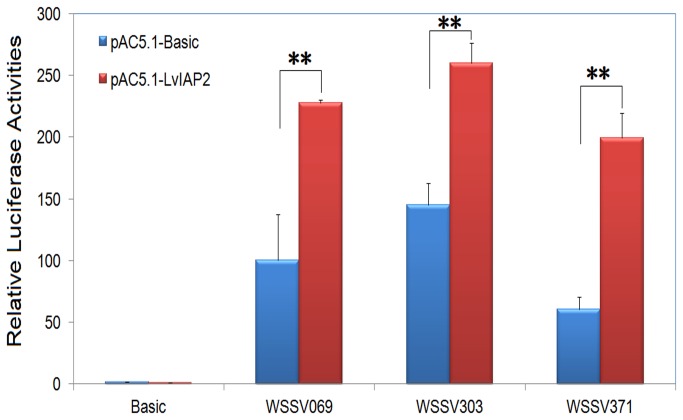
Activation of the promoters of WSSV069 (ie1), WSSV303, and WSSV371 by overexpression of LvIAP2 in
Drosophila
 S2cells.